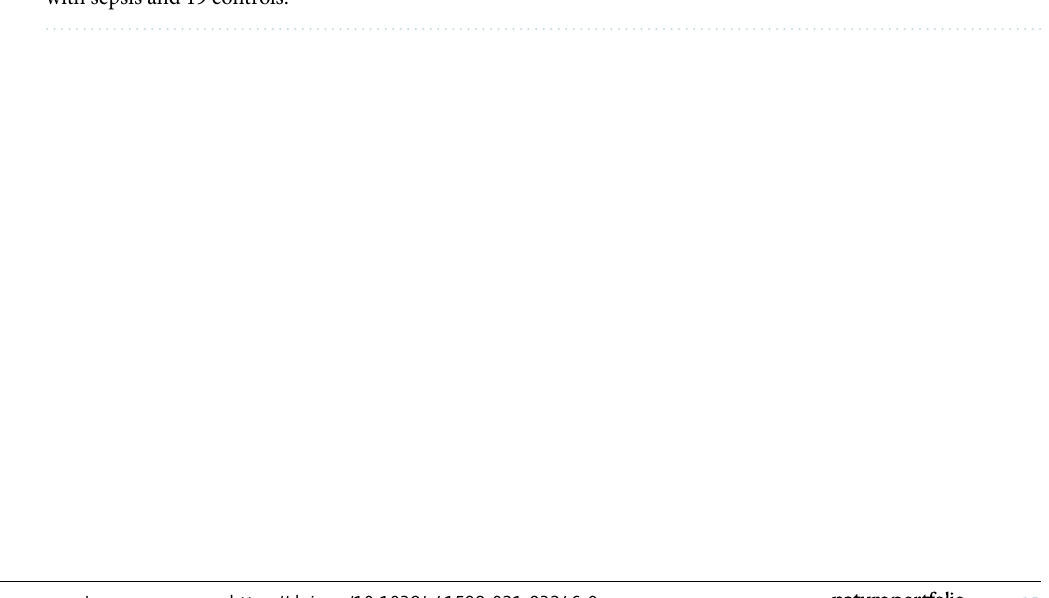
Figure 4. Expression of hsa_circRNA_104484 and hsa_circRNA_104670 in the serum exosomes of 22 patients with sepsis and 19